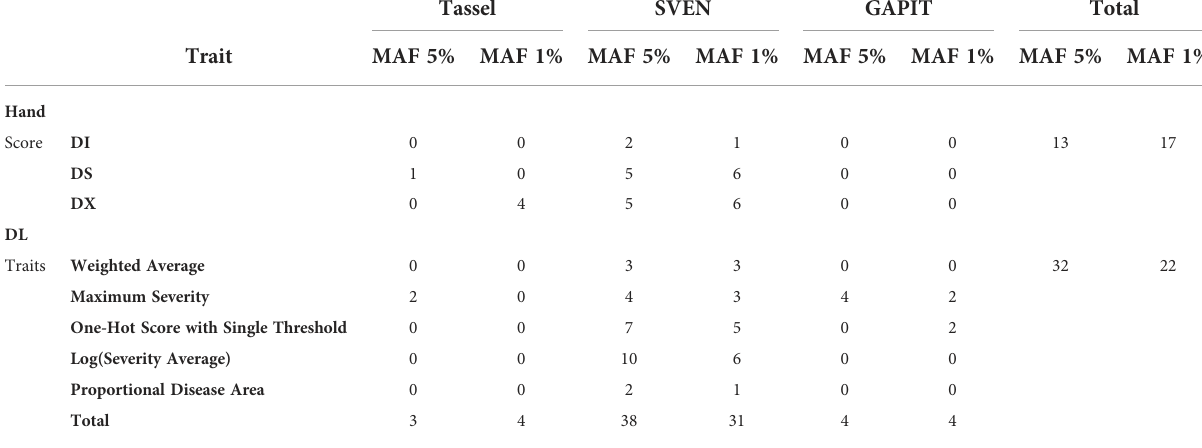
TABLE 5 Distribution of signi fi cant SNPs across programs used to run GWAS analysis (Tassel, GAPIT and SVEN) and traits with a MAF of 5% and MAF of 1%, where the MAF 1% column represents additional SNPs reported that were not reported with a MAF of 5%.